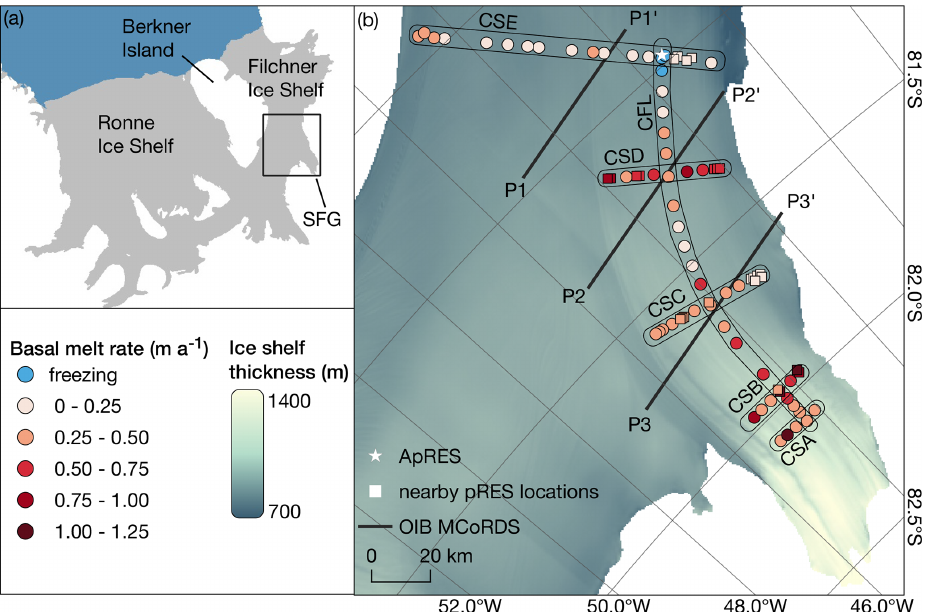
Figure 1. (a) Map of the Ronne and Filchner ice shelves (BedMachine Antarctica; Morlighem, 2020; Morlighem et al., 2020) with the marked study area (black box) near the Support Force Glacier (SFG). (b) Study area with derived basal melt rates (dots), grouped depending on their location on the central flow line (CFL) and five cross sections CSA, CSB, CSC, CSD and CSE. Nearby pRES measurements with distances < 2km are shown by squares, and the location of an ApRES station (FSE1 in Vaˇnková et al., 2020) is shown by a star. Multi- channel Coherent Radar Depth Sounder (MCoRDS) profiles (P1–P3) flown as part of NASA’s Operation IceBridge (OIB) campaign in 2016 (Paden et al., 2014, updated 2019) are shown by black lines (echograms are included in the Appendix, Fig. A1). Background colour shows the ice shelf thickness from BedMachine Antarctica (Morlighem, 2020; Morlighem et al.,